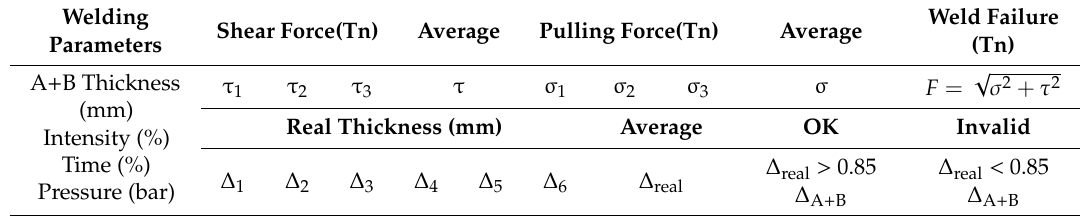
Table 3. Assessment of weld performance.